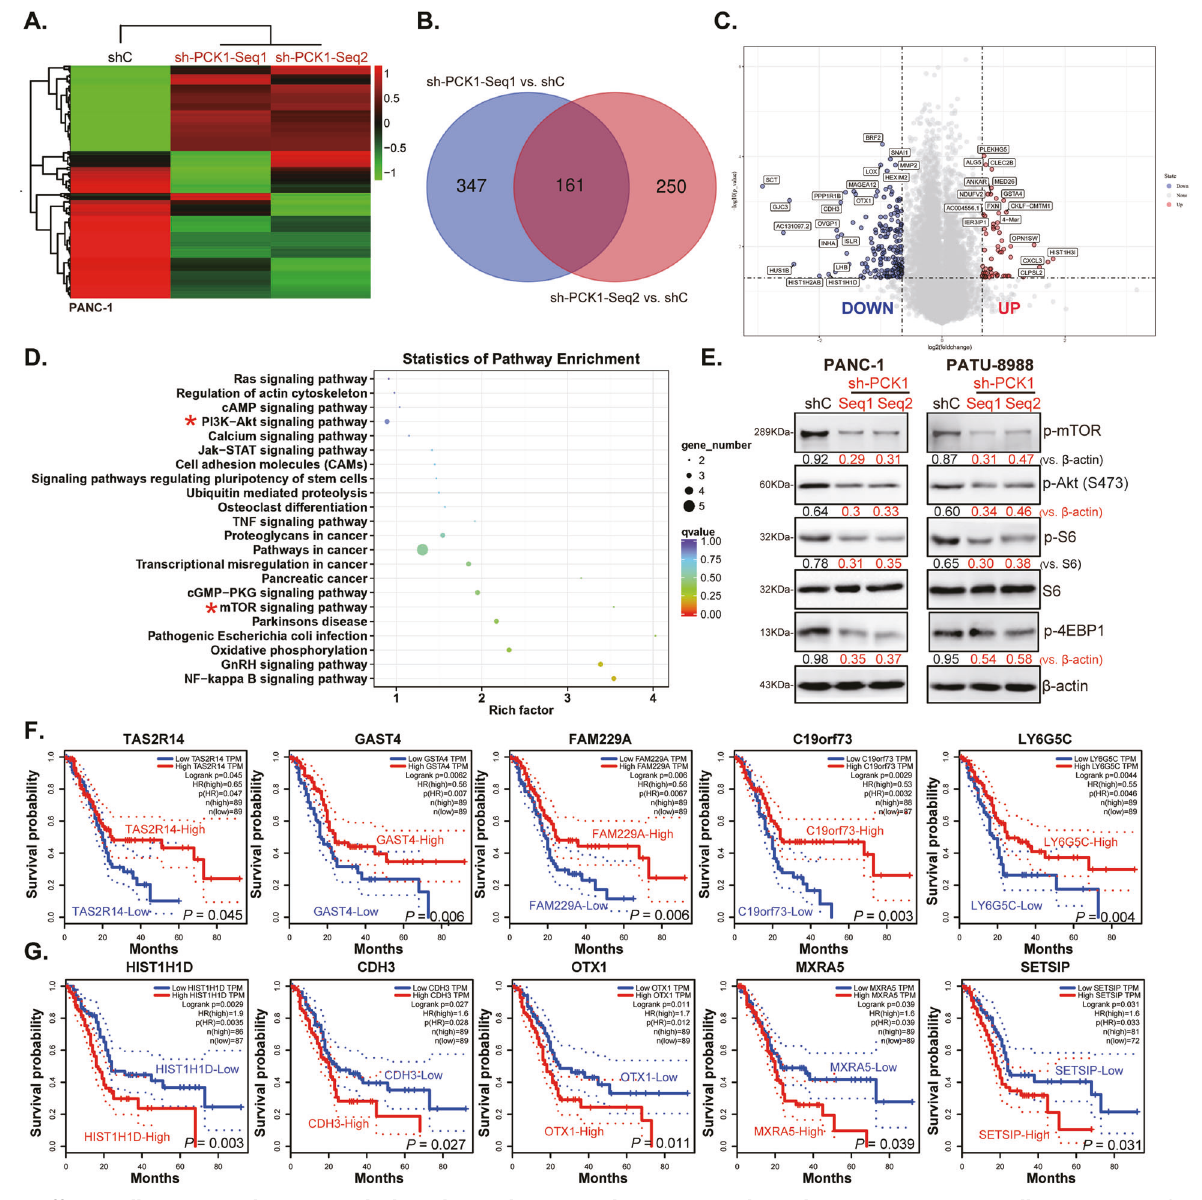
Fig. 5 Differentially expressed genes and altered signaling cascades in PCK1-silenced pancreatic cancer cells. Heat map shows all differentially expressed genes (DEGs) in PANC-1 cells expressing the applied PCK1 shRNA (vs. cells with shC, A ). Venn diagram shows 161 DGEs (both upregulated and downregulated genes) in PCK1 shRNA-expressing PANC-1 cells ( B ). Volcano plots show the representative DEGs in PCK1 shRNA-expressing PANC-1 cells ( C ). Signaling pathway analyses of DEGs performed with the KEGG and R software packages are shown ( D ). Western blotting was used to detect AKT-mTORC1 signaling activation in PANC-1 cells bearing the PCK1 shRNA ( “ sh-PCK1-Seq1 ” or “ sh- PCK1-Seq2 ” ) or lentiviral scramble control shRNA ( “ shC ” ) ( E ). TCGA Kaplan – Meier survival analyses according to expression levels of representative DEGs that were upregulated ( F ) and downregulated ( G ) in PCK1-silenced